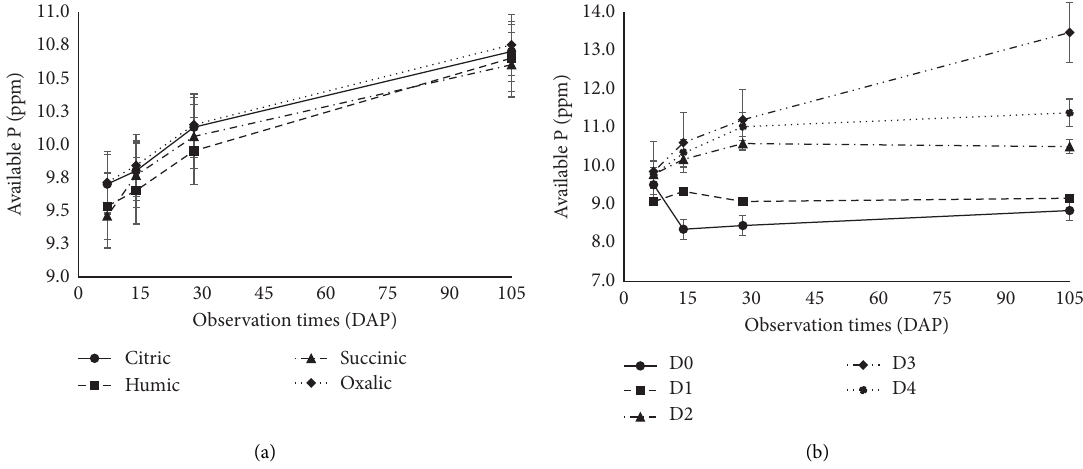
Figure 4: Efect of OA types (a) and OA concentration levels (b) on soil available P (ppm) at some observation